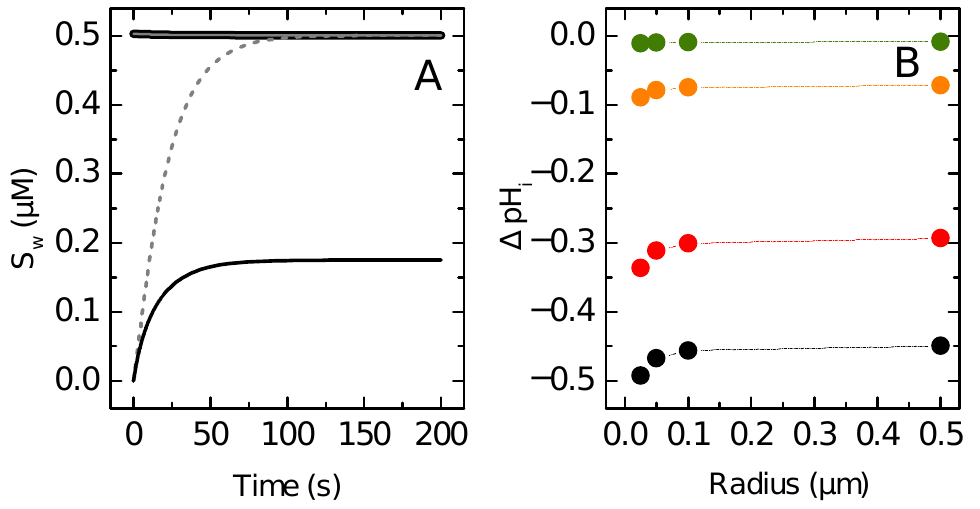
Figure 7. ( A ) Evolution of the concentration of solutes’ protonated species ( SH wo — , and SH wi (cid:5) (cid:5) (cid:5) ), and deprotonated species ( SD wo — , and SD wi (cid:5) (cid:5) (cid:5) ), for vesicles with a 100 nm radius in the absence of additional pH buffers inside the vesicles. Only the concentration of the species in the aqueous phase is shown, the concentration of the corresponding species in the membrane is the same because K P =